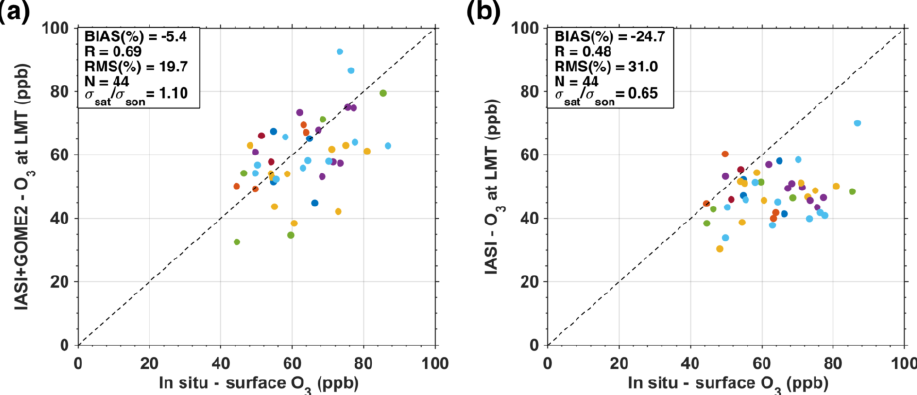
Figure 2. Evaluation of the capacity of IASI + GOME2 to retrieve near-surface ozone: comparisons of (a) IASI + GOME2 and (b) IASI- only retrievals with surface ozone observations from 11 EANET/GAW surface in situ stations over East Asia, during the two greatest East Asian ozone pollution events in springtime 2009 (from 4 to 9 April and from 4 to 9 May 2009). The figures show cases with vertical gradient of ozone concentration between the surface and 2km altitude below 10ppbkm − 1 (according to CHASER model analysis). This is a direct comparison without smoothing by averaging kernels. Colours indicate different days of the comparison. The symbol σ sat /σ sonde is the ratio between the SDs of the sonde data and the satellite retrievals. Ozone concentrations in the LMT are provided as volume mixing ratios in ppb, calculated as the ratio of LMT partial columns (in molcm − 2 ) of ozone and air (in Figs. 2–14 and also used for CO and other partial columns).